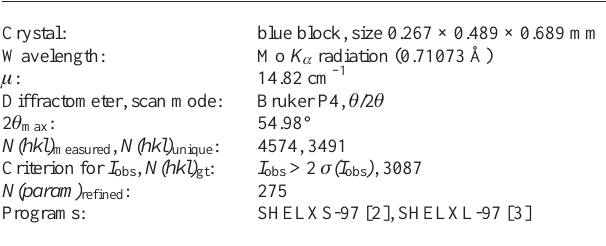
Table 1. Data collection and handling.